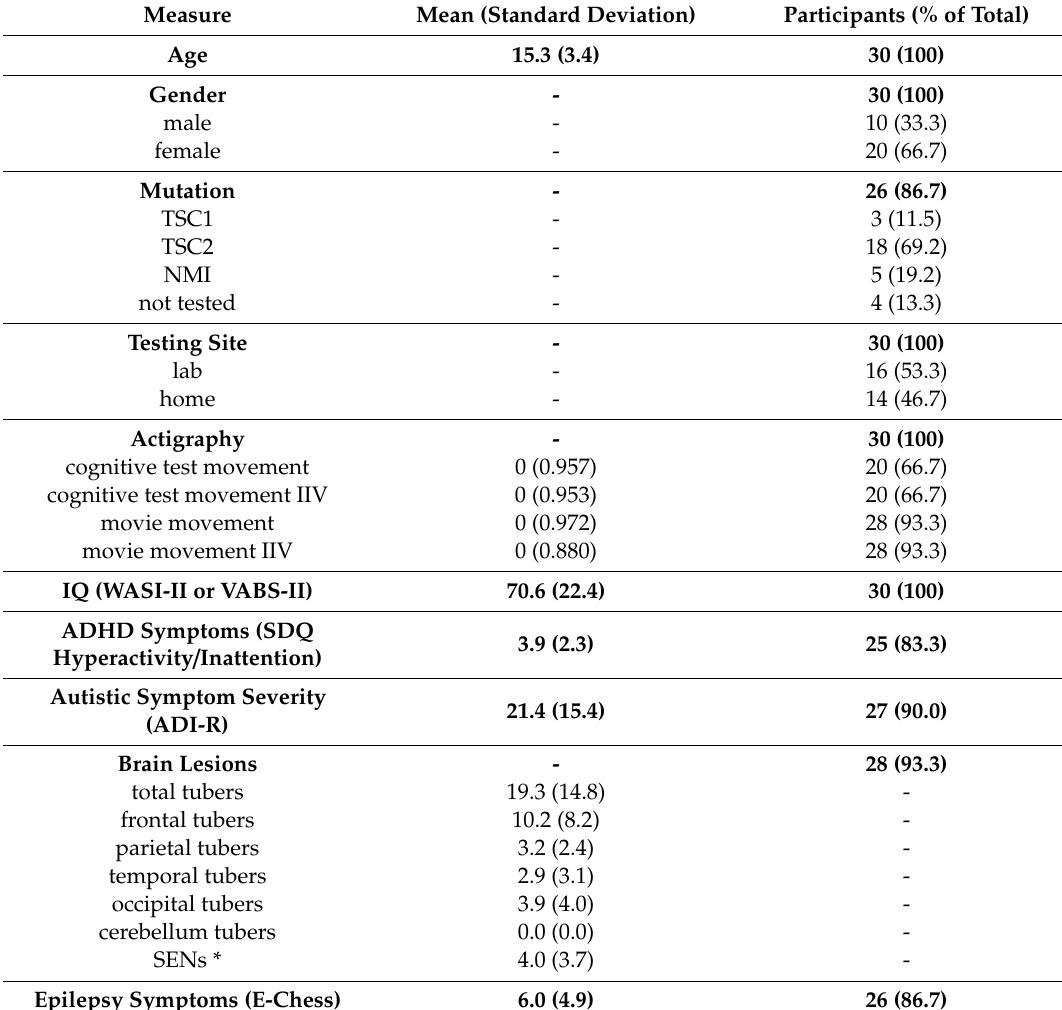
Table 1. Sample characteristics and descriptive statistics for all assessments. NMI = no mutation identified, IIV = inter-individual variability, CoV = coe ffi cient of variation, WASI-II = Wechsler Abbreviated Scale of Intelligence II, VABS = Vineland Adaptive Behavior Scale II, SDQ = Strengths and Di ffi culties Questionnaire, ADI-R = Autism Diagnostic Interview Revised, E-Chess = Early Childhood Epilepsy Severity Scale, SENs = subependymal nodules. * SEN data only available for 24 participants. Note that actigraph measurements were standardised using z-scores and so the means are zero and the SDs are close to